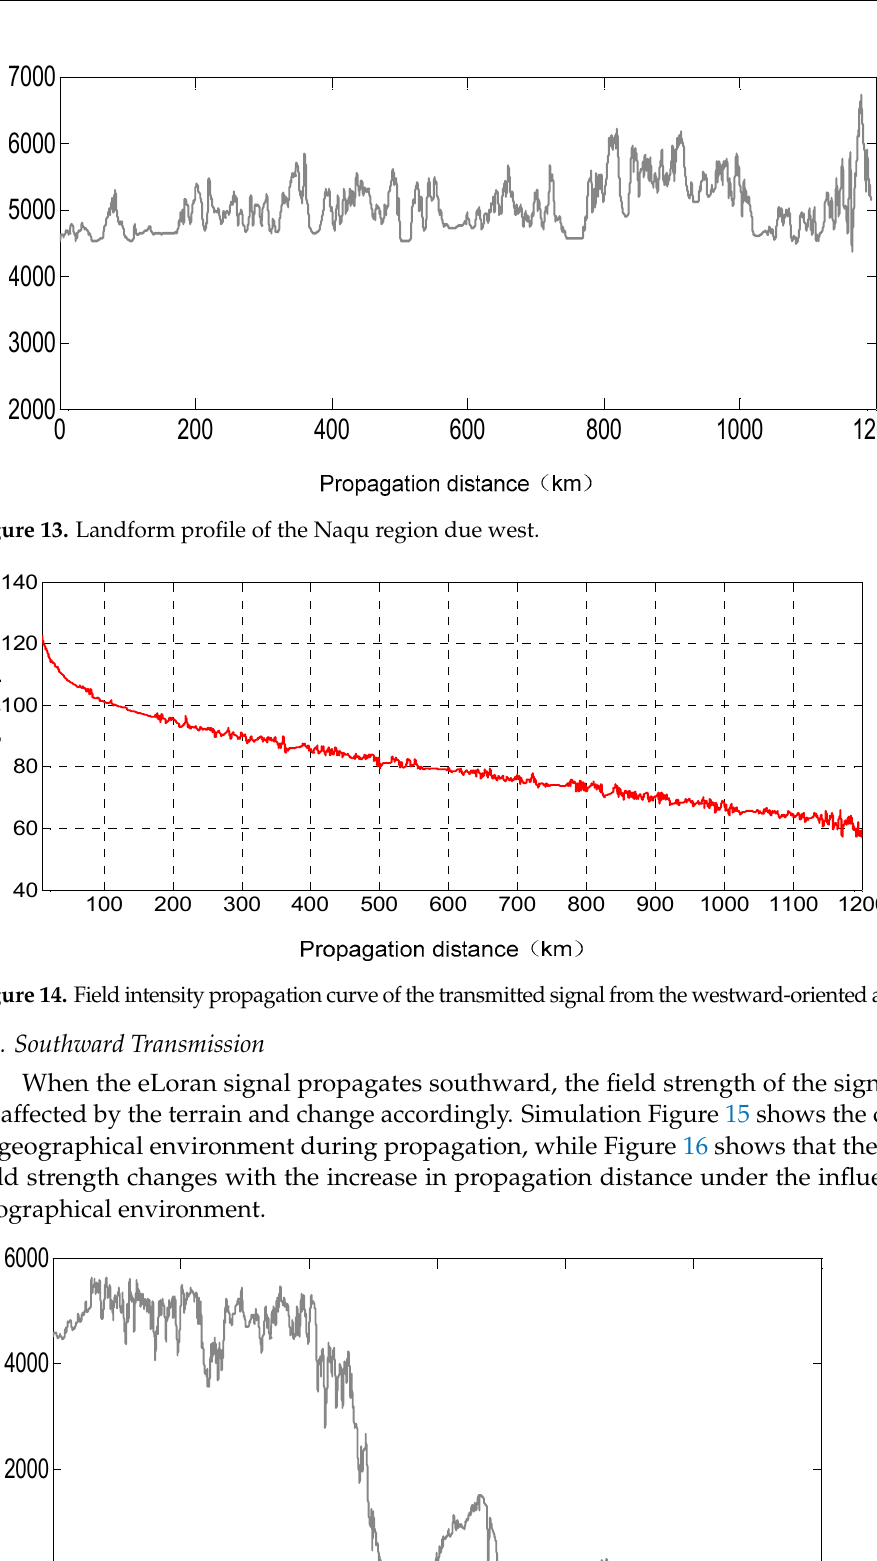
Figure 15. Landform profile of the Naqu region due south.